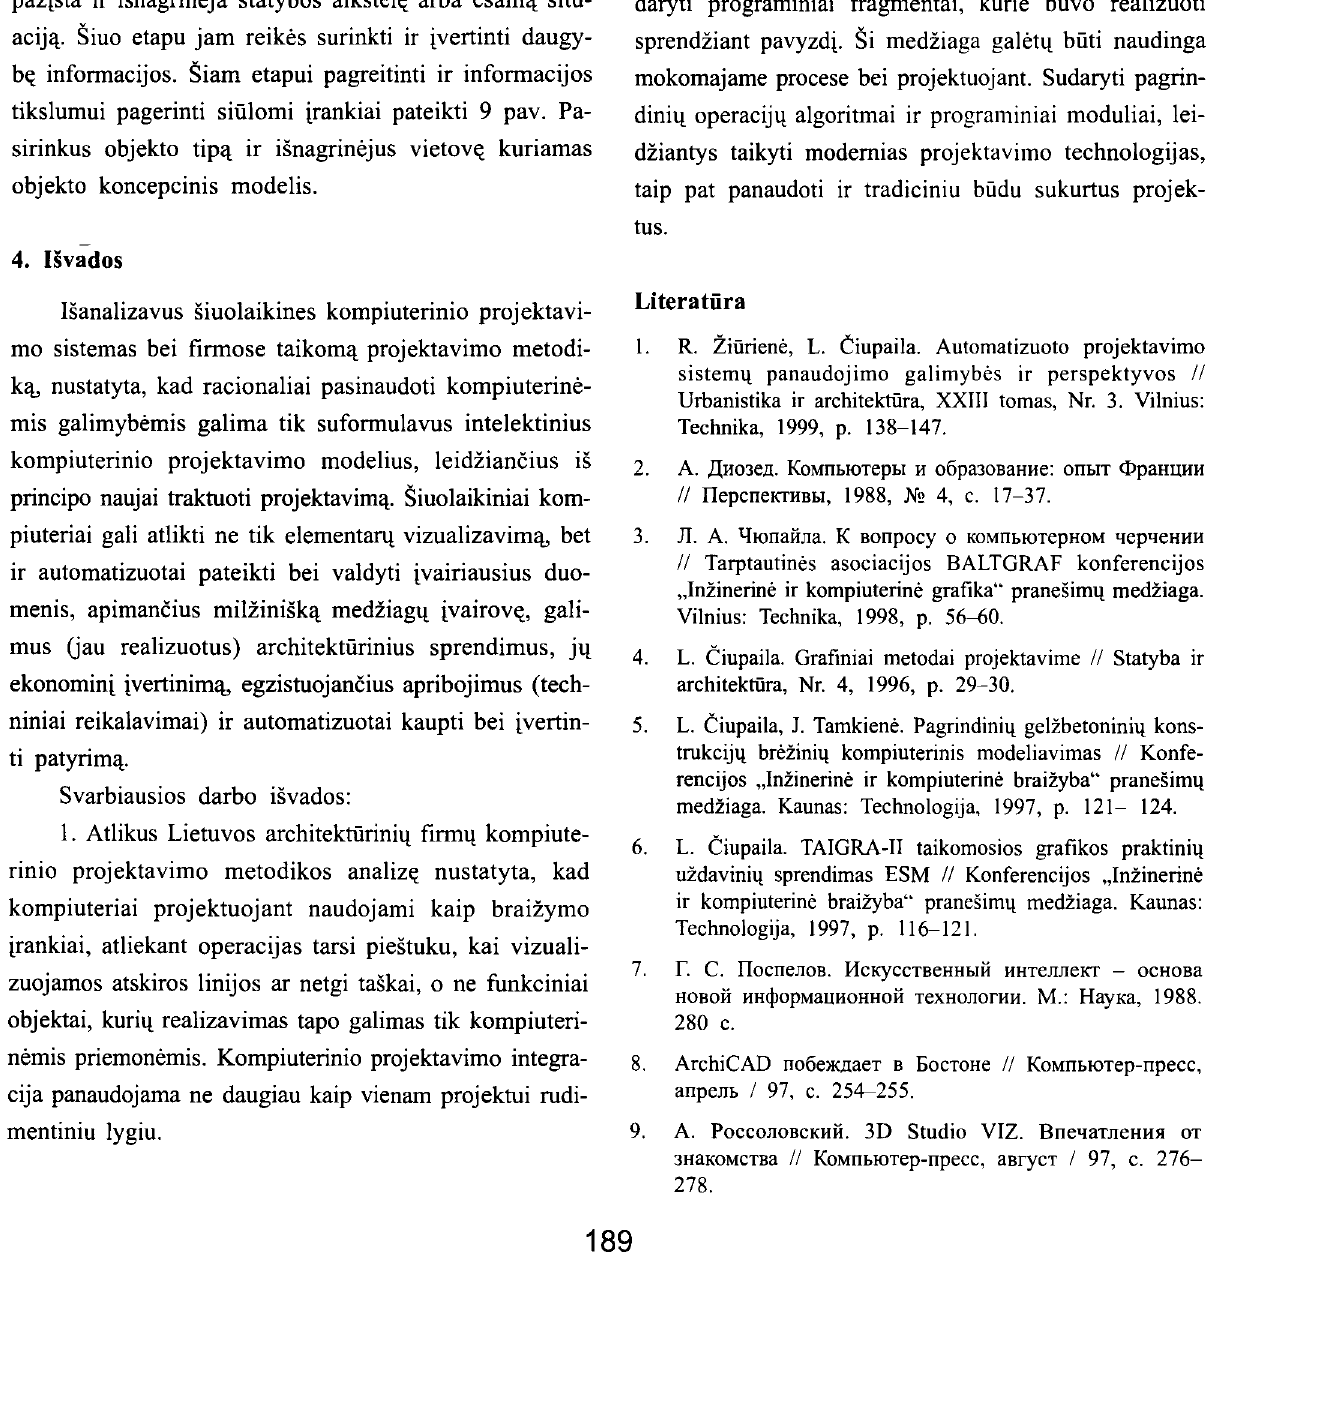
Fig 9. Tools for design of an entirely new object Projektavimo pradineje stadijoje architektas susi pazista ir isnagrineja statybos aikStel(( arba esam~ situ acij~. Siuo etapu jam reikes surinkti ir ivertinti daugy b(( informacijos. Siam etapui pagreitinti ir informacijos tikslumui pagerinti siUlomi irankiai pateikti 9 pav. Pa sirinkus objekto tip~ ir isnagrinejus vietov(( kuriamas objekto koncepcinis